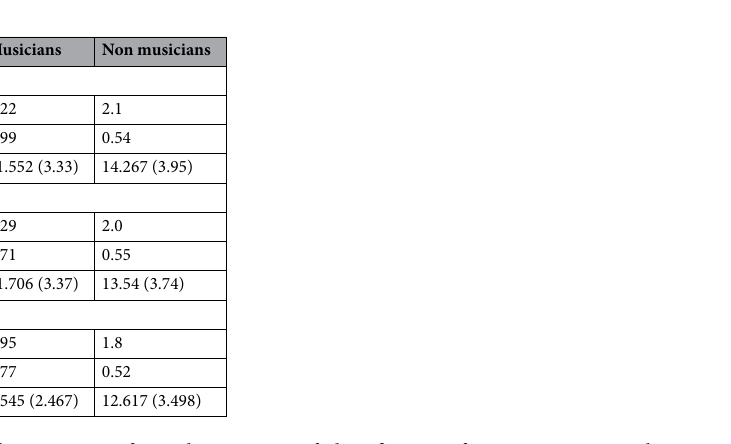
Table 2. Behavioral results: Logit transformed percentage of identification of correct patterns and comparison to the chance level via a one-sample t-test for each group.